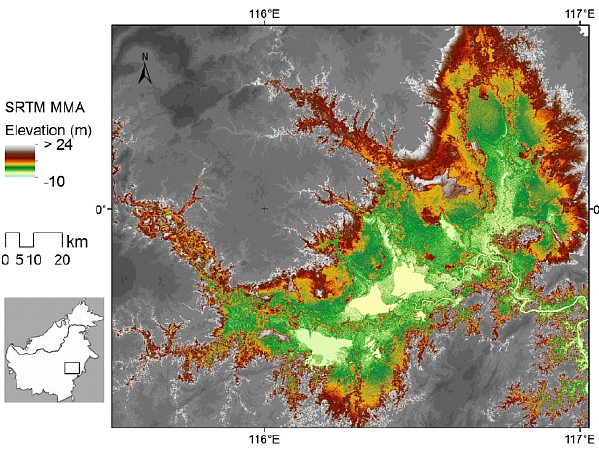
Fig. 1. Land use/land cover map of the Mahakam river basin based on PALSAR images of 2007 (Hoekman et al., 2010). The black line indicates the catchment boundary.